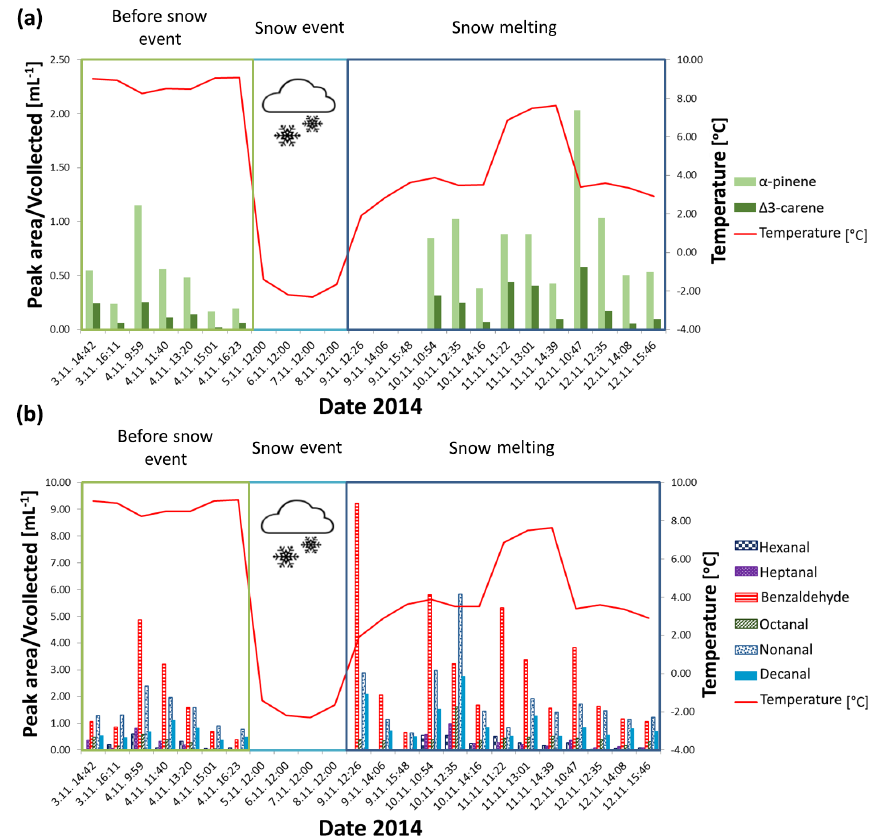
Figure 5. Observation of an increase in monoterpene (a) and aldehyde (b) atmospheric amounts during a snow melt event in November 2014 (daily average temperatures were used on days when sampling was not